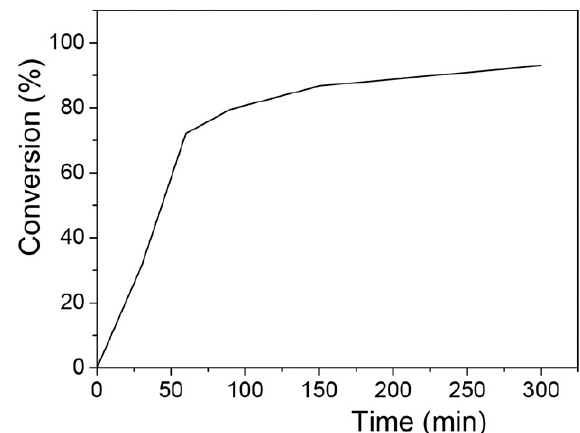
Figure 5. Kinetic monitoring of cis -cyclooctene epoxidation with TBHP–H 2 O in the presence of the